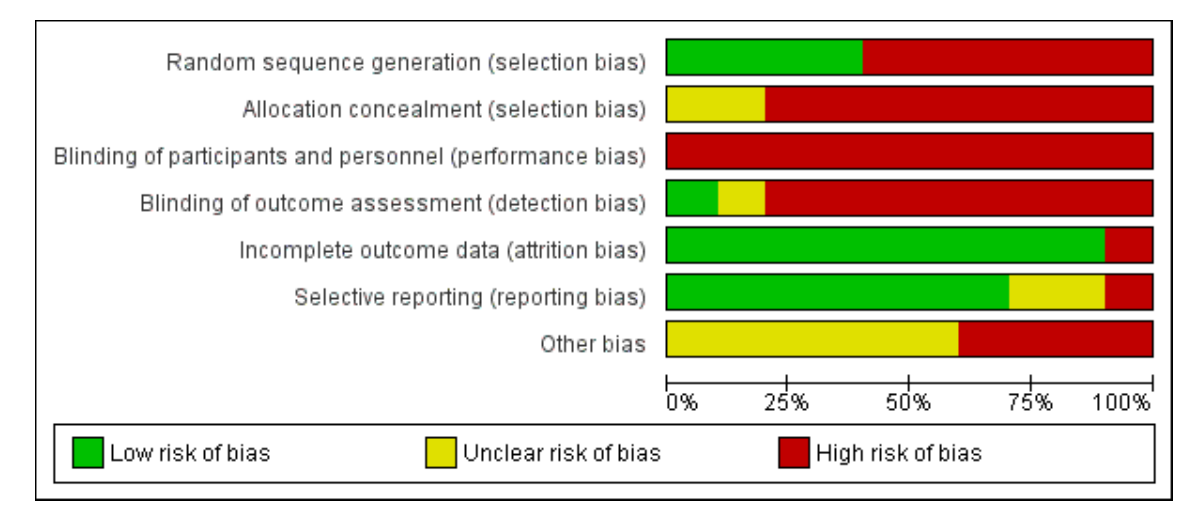
Figure 3. Risk of bias graph.